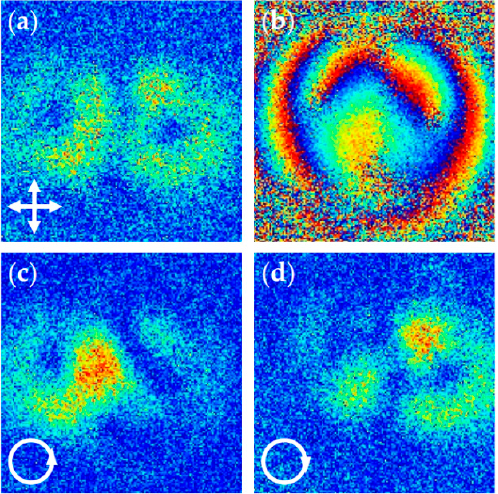
Figure 4. ( a ) Intensity and ( b ) phase distribution of the detected vertically polarized components of the diffracted beams at 1 THz for horizontally polarized incident; the measured intensity pattern for vertical polarization component for ( c ) LCP and ( d ) RCP incident THz beam.